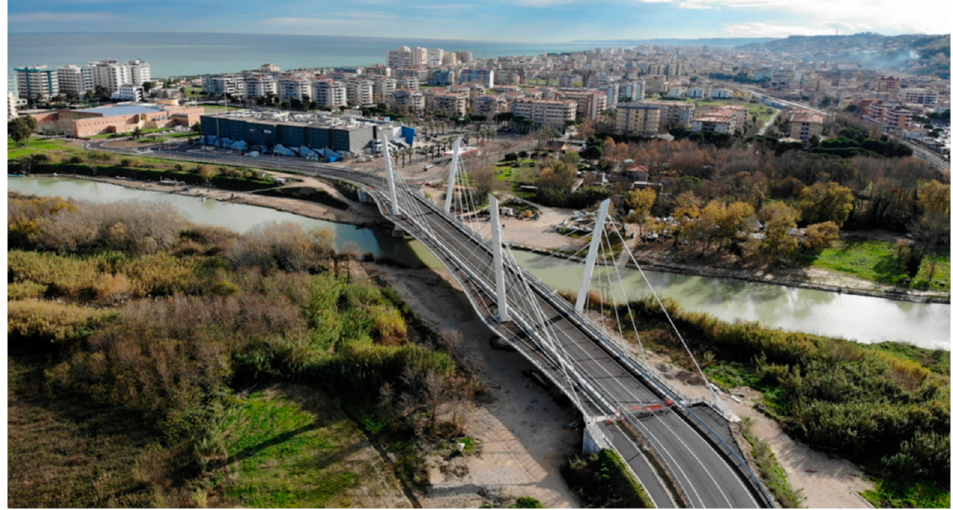
Figure 1. Overview of the Filomena Delli Castelli bridge.